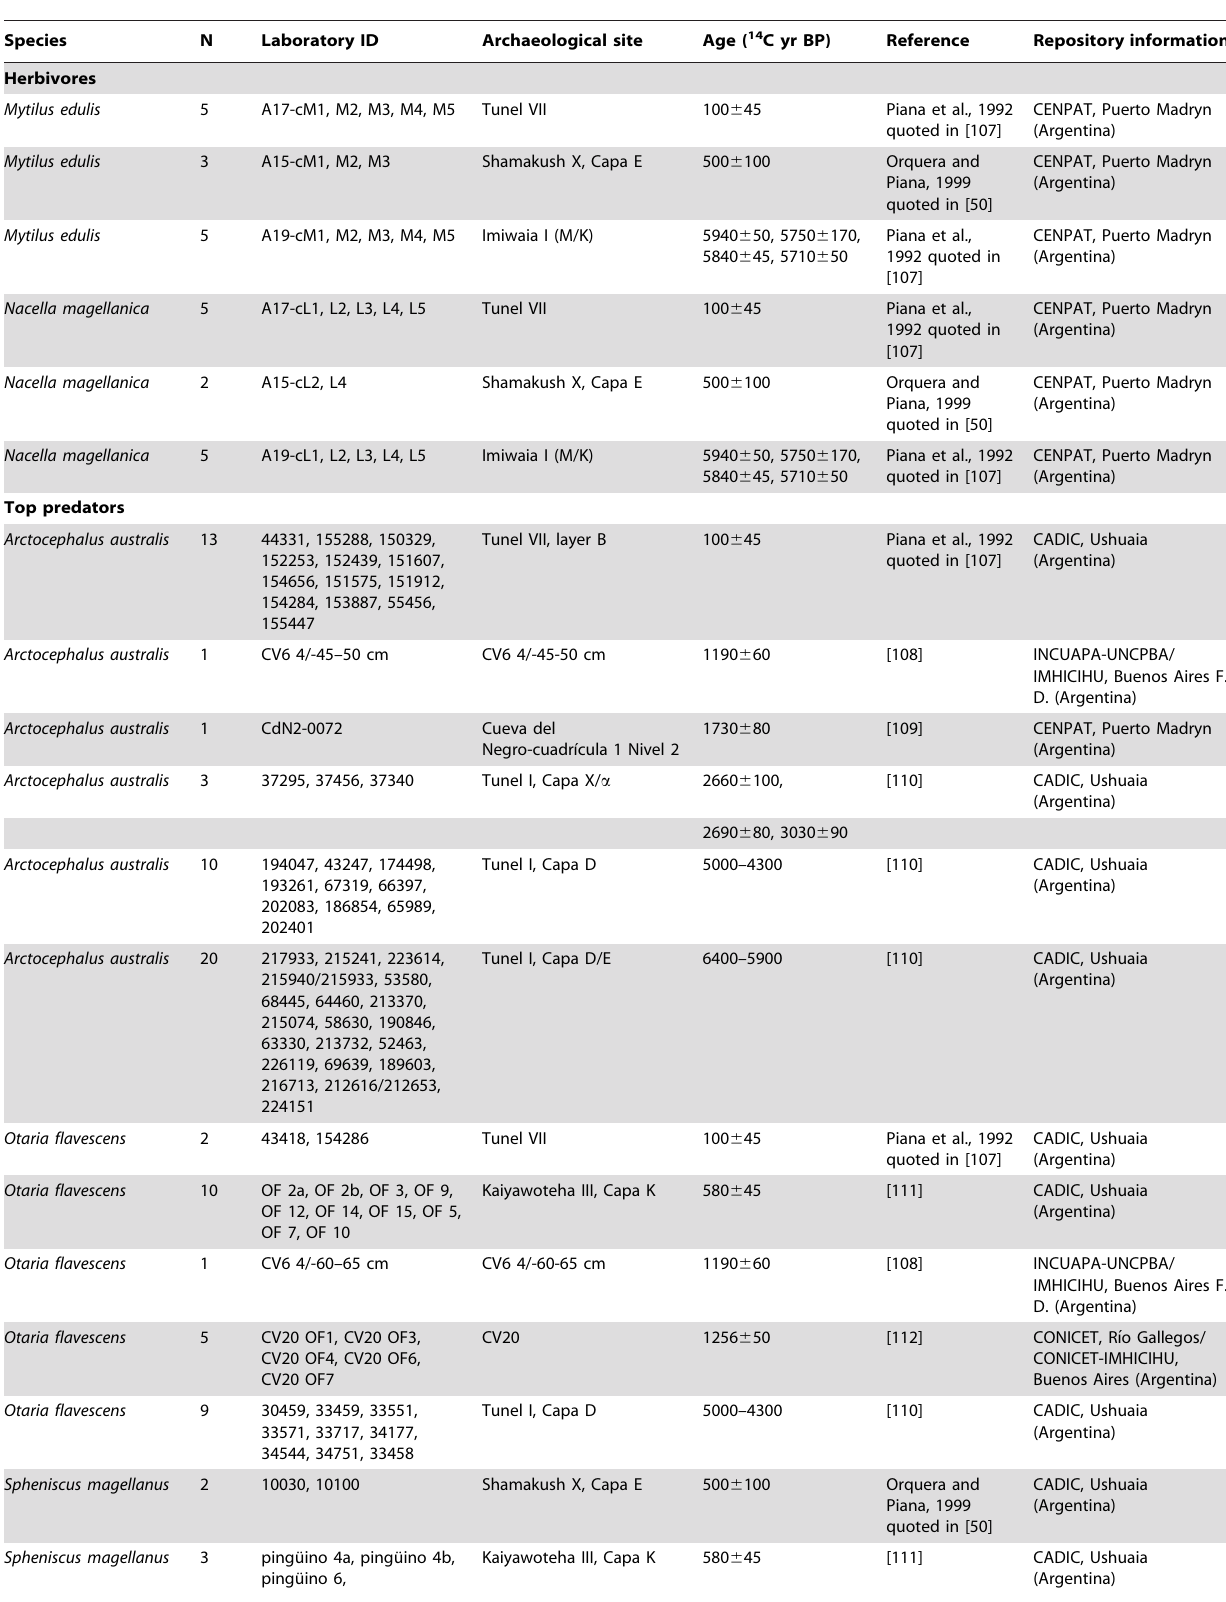
Table 3. Archaeological samples from southern